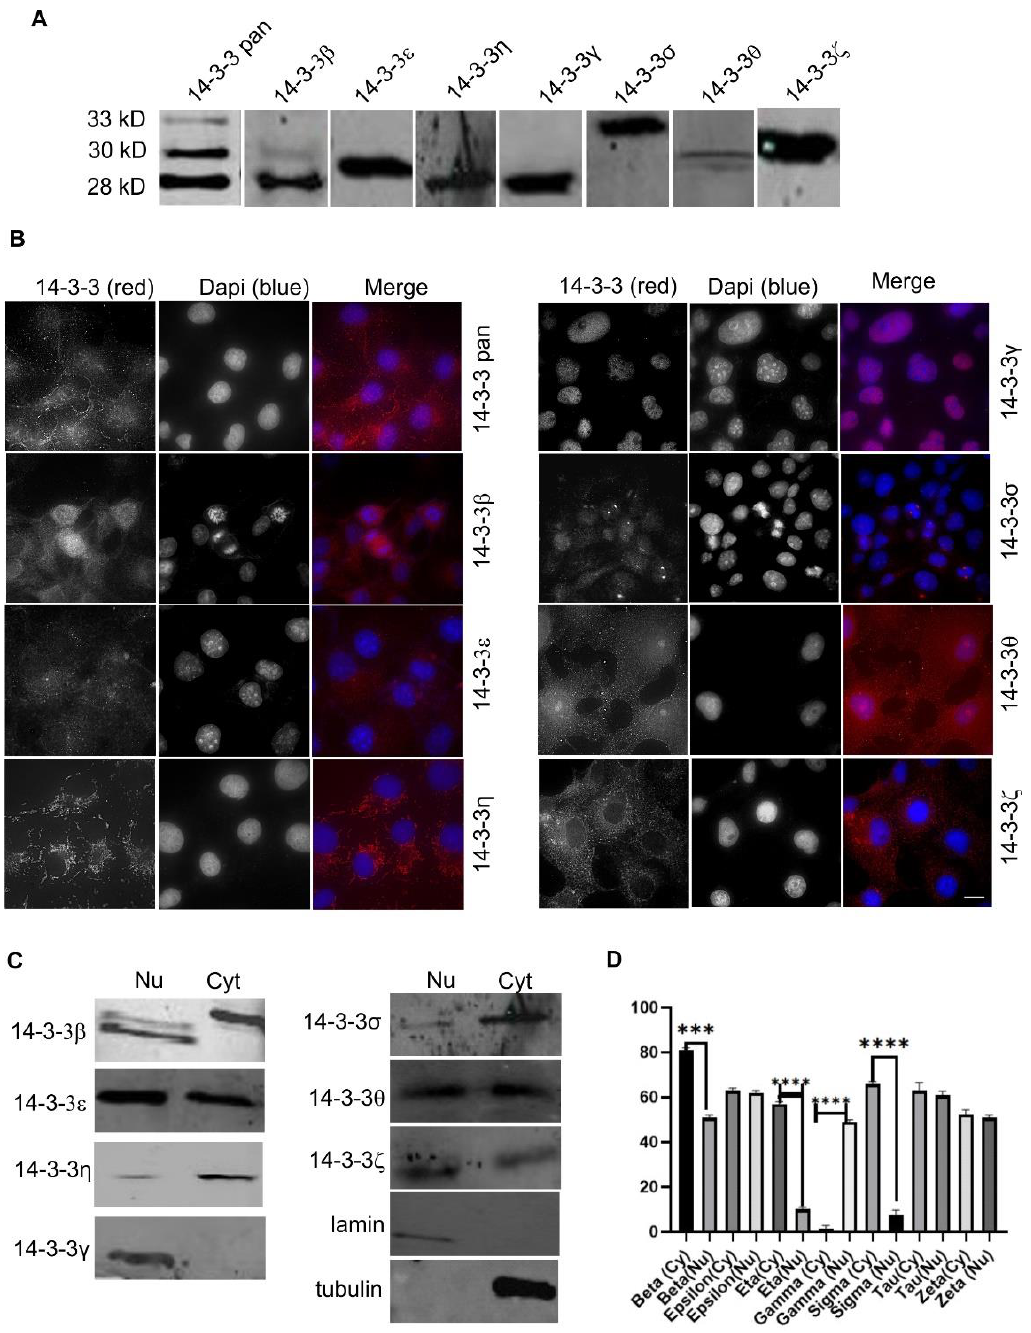
Figure 1. Subcellular localization of total 14-3-3 protein and the seven 14-3-3 isoforms in Cos-7 cells. The total 14-3-3 protein was determined by a pan14-3-3 antibody. Each 14-3-3 isoform was determined by antibodies to each specific isoform. Immunoblotting, immunofluorescence, and subcellular fractionation were performed as described in Materials and Methods. ( A ) The expression level of total protein and seven isoforms of 14-3-3 protein by immunoblotting in Cos-7 cells. The expression of tubulin was used as a control. ( B ) Subcellular localization of pan14-3-3 and seven 14-3-3 isoforms in Cos-7 cells by immunofluorescence. 14-3-3 proteins were revealed by TRITC (red) and the chromatin was stained by DAPI (blue). Scale bar = 10 µ m. ( C ) Nuclear and cytoplasmic localization of 14-3-3 proteins by subcellular fractionation followed by immunoblotting. A-Tubulin was used as a marker for cytoplasm and lamin A was used as a marker for the nucleus. ( D ) Quantification of the results from ( C ). each value is the average of three experiments and the error bar is the standard error. **** p < 0.0001; *** p < 0.001.